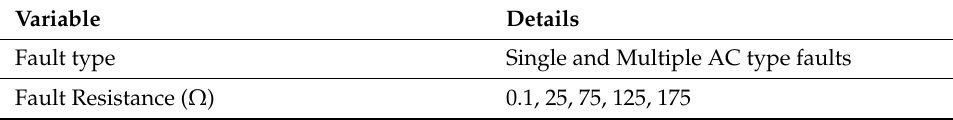
Table 4. Case studies for external faults in testing